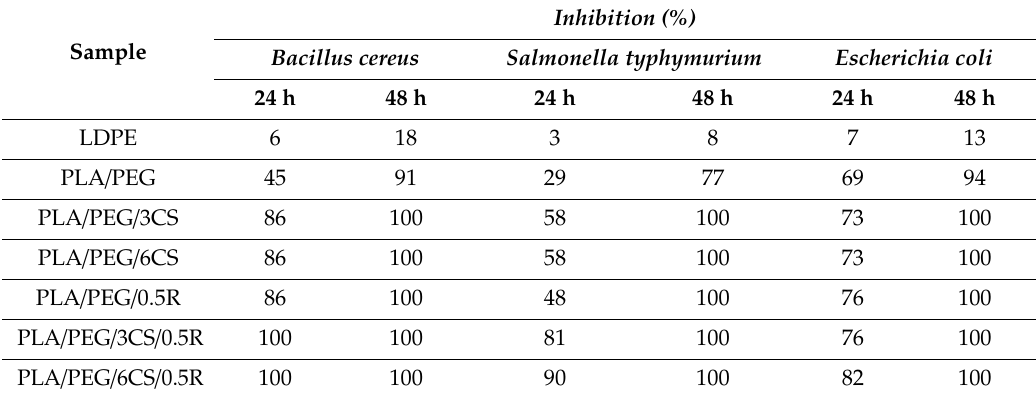
Table 5. Antibacterial activity of the chitosan and rosemary alcoholic extract incorporated into PLA-based materials against Bacillus cereus, Salmonella typhymurium and Escherichia coli